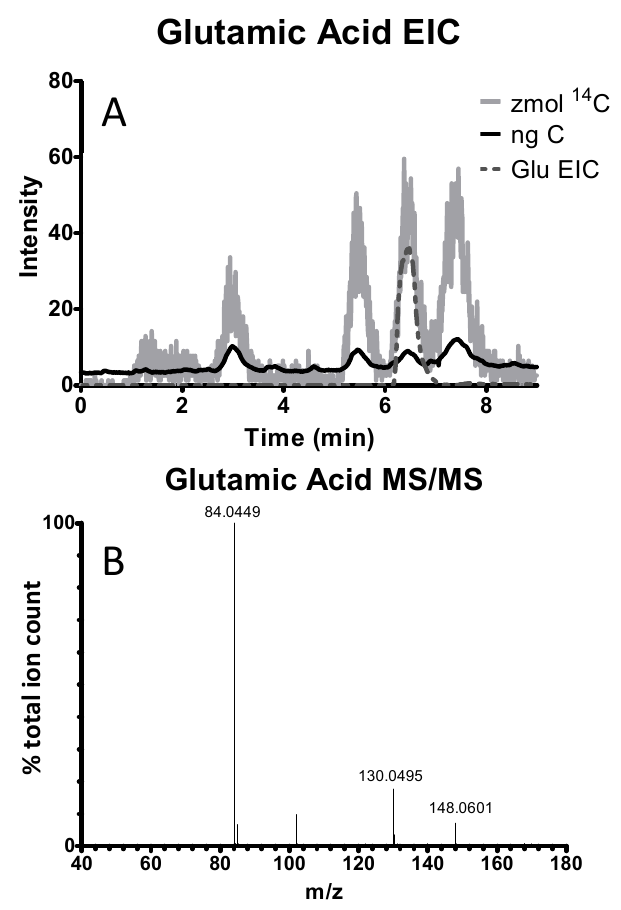
Figure 3. PAMMS analysis of carbon-14 labeled amino acid standards, showing ( A ) extracted ion chromatogram (EIC) and ( B ) mass spectrum for glutamic acid.